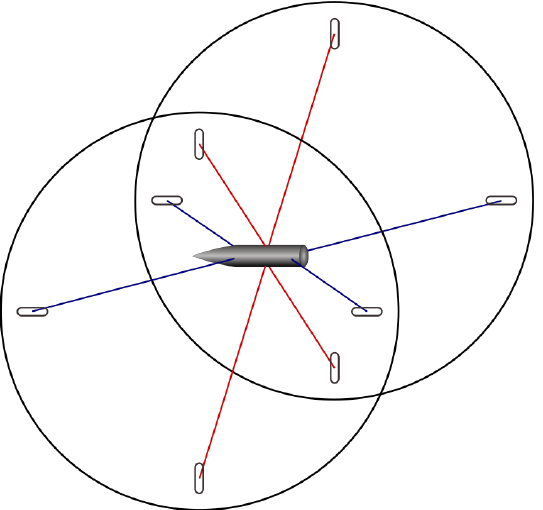
Figure 1. Sketch of the wire suspension